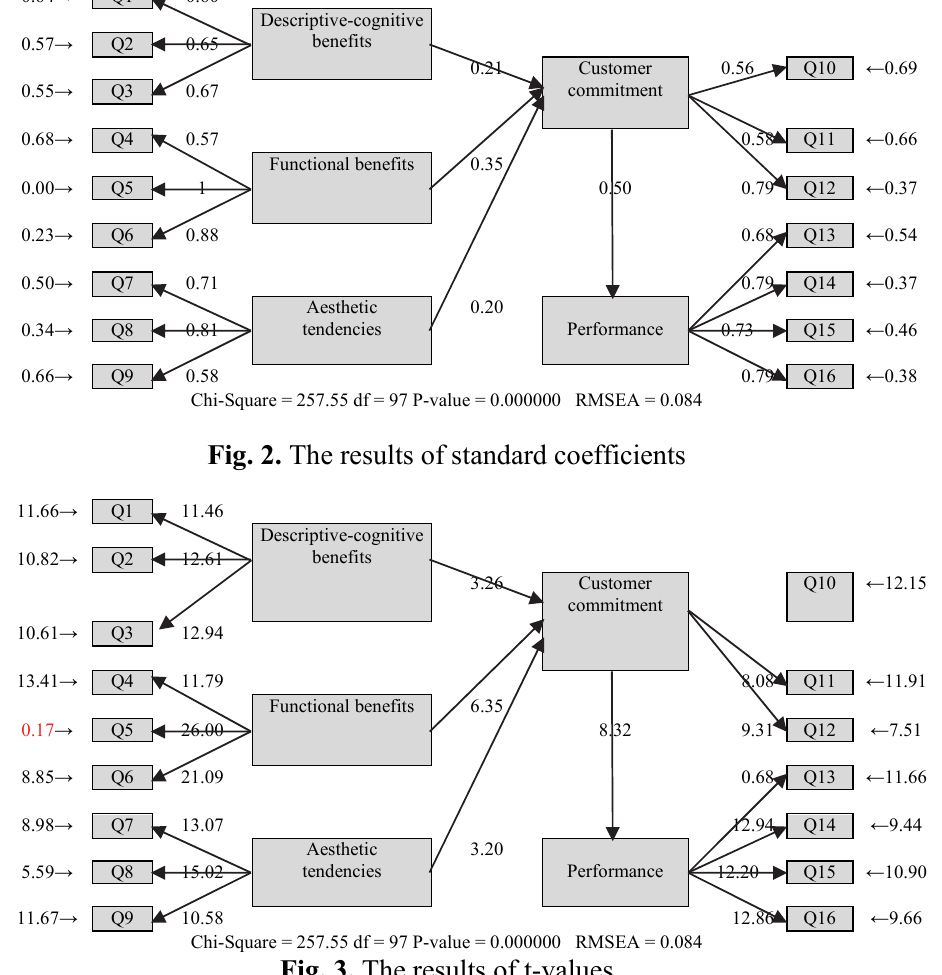
Fig. 3. The results of